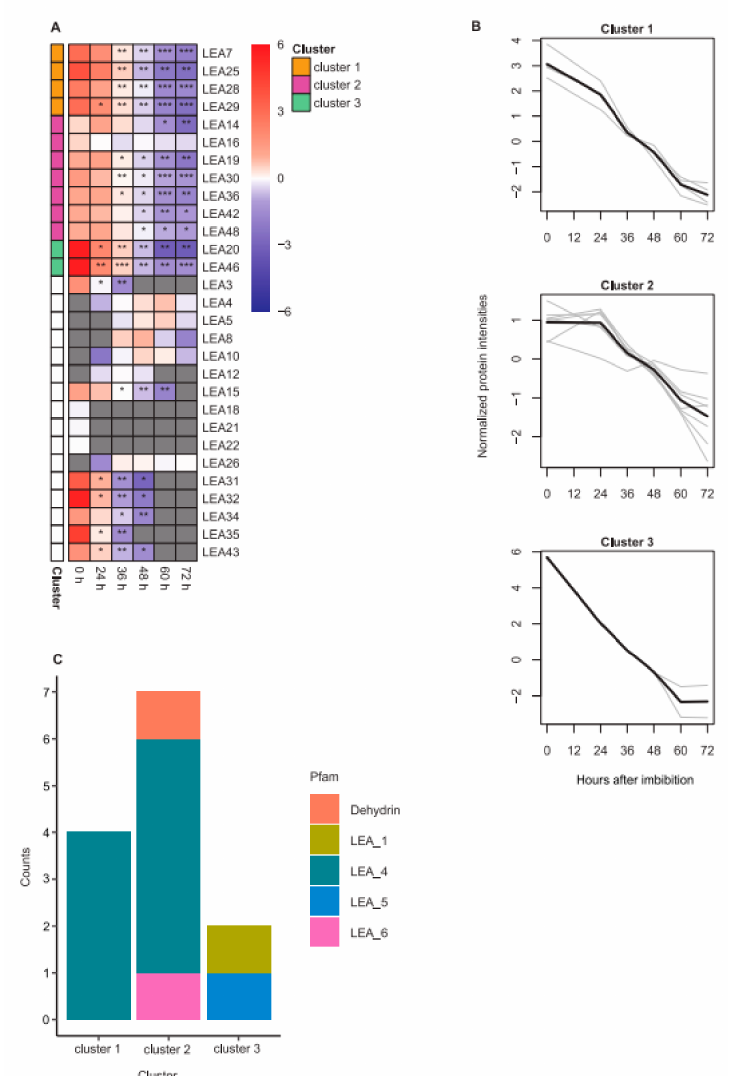
Figure 6. LEA protein abundance in dry seeds (DS), germinating seeds and seedlings and their kinetic patterns and Pfam distributions. ( A ) LEA protein abundance in DS and at different time points after imbibition. The color gradient represents the log 2 -median transformed means of mass spectral LFQ intensities ( n = 3). Gray boxes represent missing values at the indicated time point. Levels of significance comparing LEA protein abundance in germinating seeds and seedlings to DS (unpaired two-sided t -test) are indicated by asterisks (* p < 0.05; ** p < 0.01; *** p < 0.001). LEA proteins are listed according to their LEA ID and corresponding clusters (cluster 1–3) as determined by k-means clustering. Each cluster is represented by a unique color. LEA proteins excluded from k-means clustering are depicted in white. ( B ) Patterns of LEA protein abundance as determined by k-means clustering. Gray lines represent individual proteins while black lines show the mean of each cluster. ( C ) Counts of LEA proteins in different Pfam groups in each cluster. Each Pfam group is represented by a unique